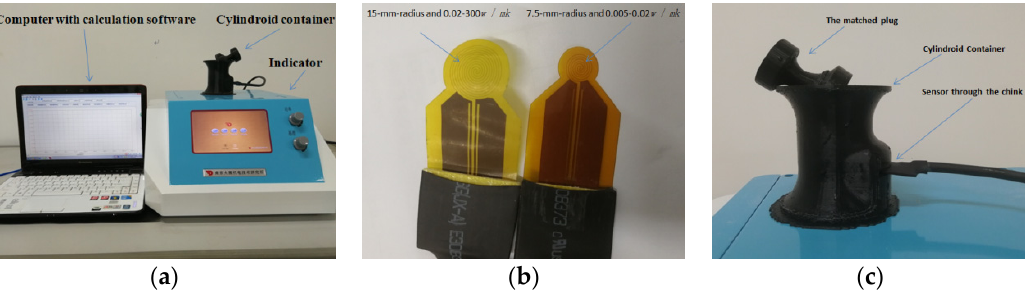
Figure 6. The TPS equipment for powder measurement ( a ) Indicator; ( b ) two sensors; ( c ) cylindroid container. Table 1. Experimental results of the HGM powders.